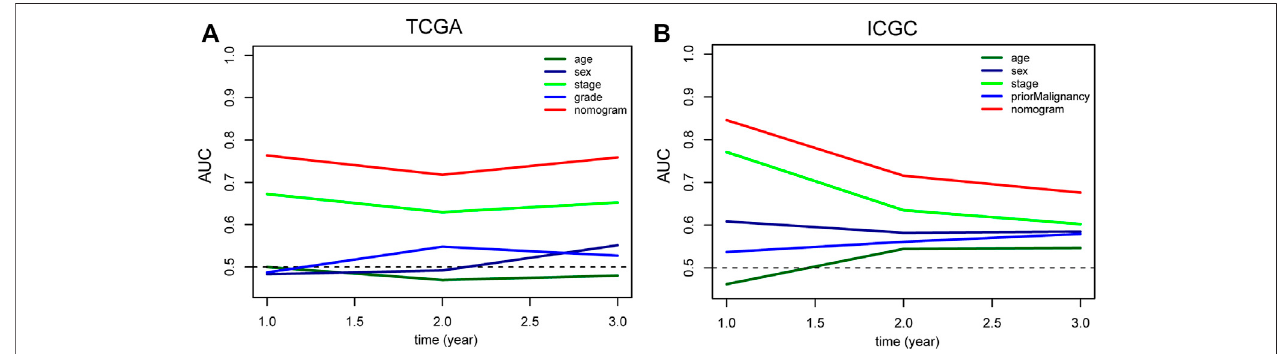
FIGURE 8 | Comparison of the predictive value of nomogram and other clinicopathological features in TCGA (A) and ICGC (B) HCC cohort. TCGA, The Cancer Genome Atlas; ICGC, International Cancer Genome Consortium; HCC, Hepatocellular carcinoma.